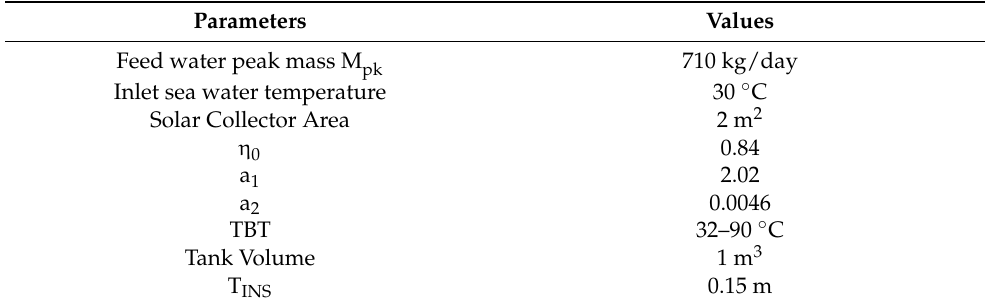
Table 2. Model parameters used for a simulation case study for Las Vegas USA.